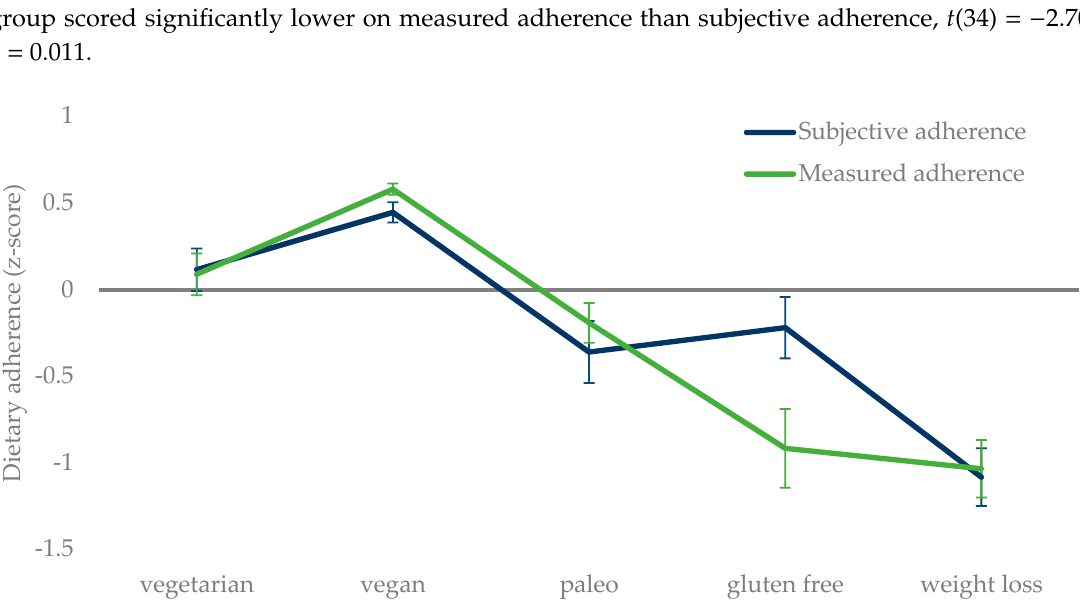
Figure 1. Adherence to one’s dietary pattern differed between dietary groups. Note. Error bars represent standard errors.